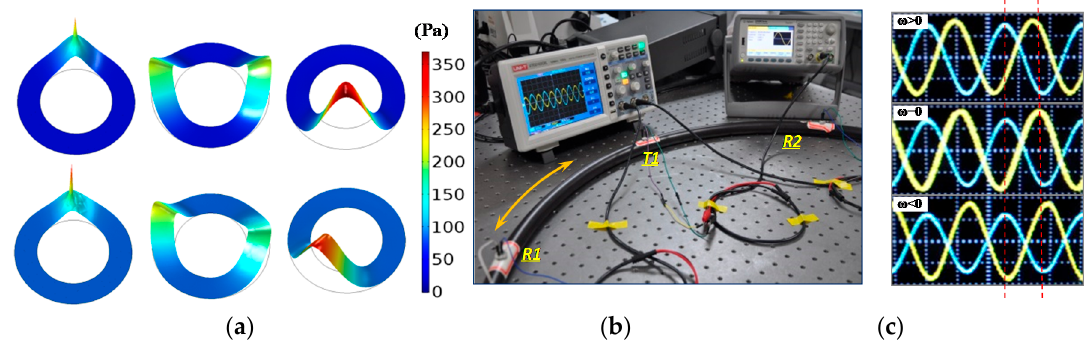
Figure 1. ( a ) Simulated sound wave propagating in a circular air duct when the air is stationary (above) and flowing (below). The setting of (below) is equivalent to the situation where the air keeps stationary while the frame (together with the sound transmitter and receiver(s)) rotates in the opposite direction. The out-of-plane displacement is the height expression of acoustic pressure (Pa). ( b ) Emulation test with a hula-hoop as the circular air duct. Diameter of the duct is about 80 cm. Three 40 kHz commercial ultrasonic ceramic transducers are installed inside the duct as acoustic transmitter and receivers. The transmitter and two receivers are marked as T1, R1 and R2, respectively. ( c ) Test results of ( b ). The phase difference between R1 and R2 changes when the ring rotates in clockwise and counterclockwise directions at ≈ 10°/s. The oscilloscope time base is 10 μ s/div.